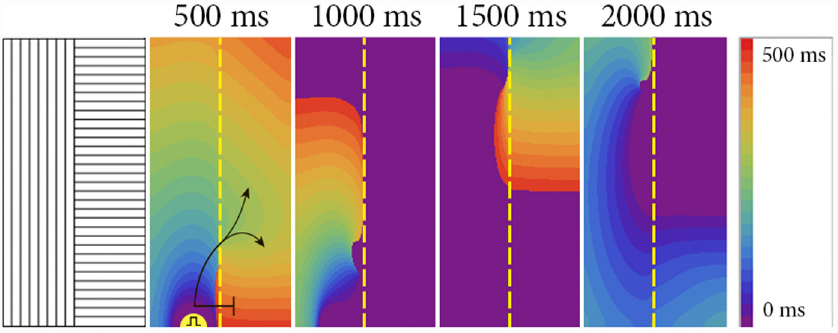
Fig 8. Formation of transient reentry (ectopic beats) at the border between areas with orthogonal fiber orientation. Two stimuli were applied 6 mm from the border with a delay of 500 ms. The AR is 2.0 and [ K + ] o is 10 mM. Size of the tissue: 6.4 cm x 3.2